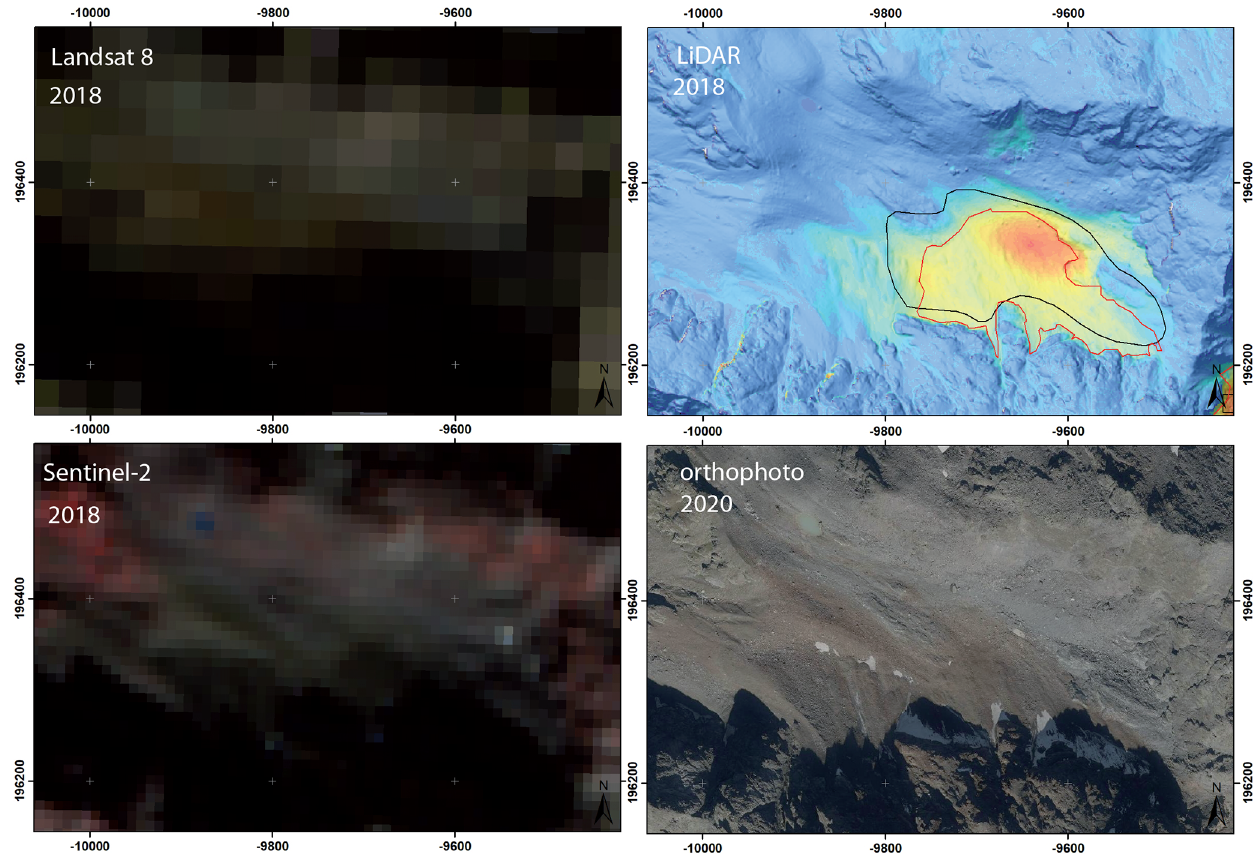
Figure 12. Representation of the debris-covered glacier Schnapfenkuchl H in the Landsat 8, Sentinel-2, and lidar images (hillshade and volume change 2006–2018, colour map like in Fig. 10) and the orthophoto. The manual delineation of glacier outlines (red: based on lidar; black: based on Sentinel-2; Paul et al., 2020) is consistent for both